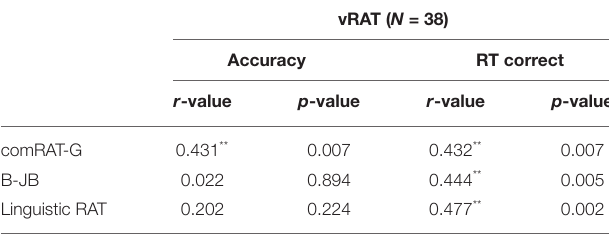
number of words listed by the participant for the three categories. TABLE 1 | Correlations of the linguistic RAT metrics with the vRAT